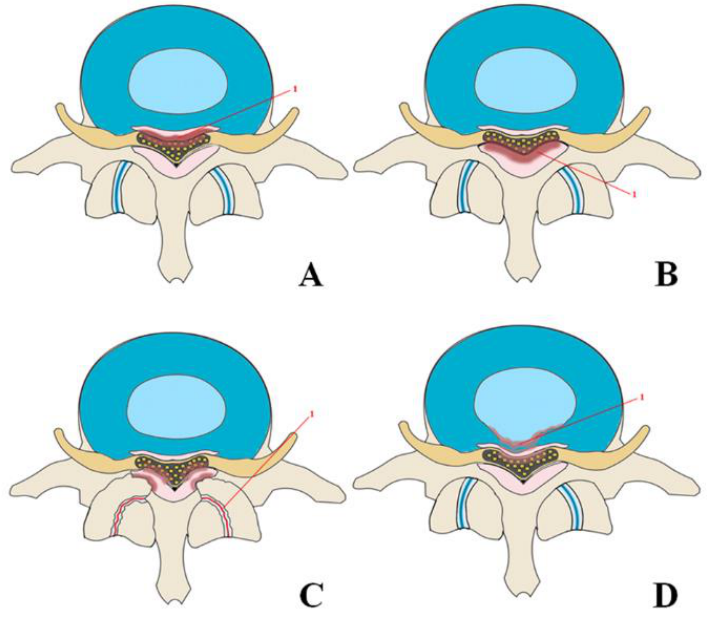
Figure 3. Mechanisms leading to spinal canal stenosis: ( A )—ossification of the posterior longitudinal ligament spinal stenosis; ( B )—ossification of the ligamentum flavum; ( C )—osteoarthritis and hypertrophy of the facet joints leading to stenosis of the spinal canal; ( D )—herniated disc. The overall prevalence of OPLL is 1.9–4.3% in Japan, 0.8–3.0% in other Southeast